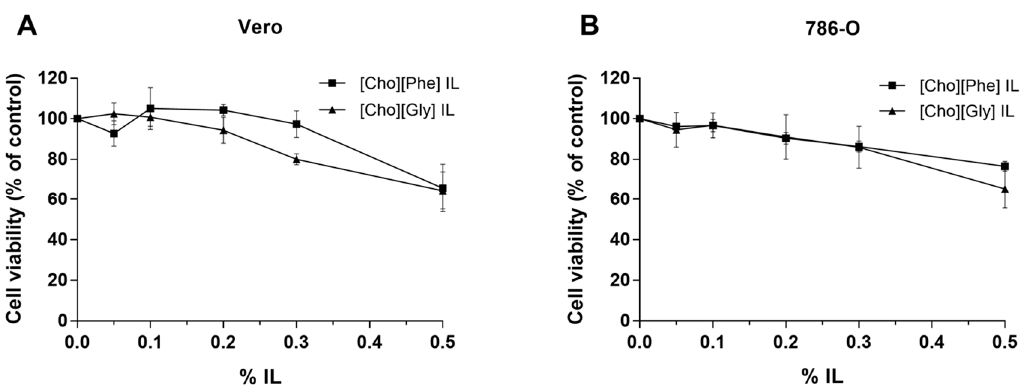
Figure 2. Cell viability of Vero ( A ) and 786-O ( B ) cells exposed to choline-amino acid ILs (0%–0.5%, v / v ). The cell viability of ILs-exposed cells (48 h) was evaluated by MTT assay. Values represent mean ± SD ( n = 2–5) and are expressed as percentages of the non-treated control cells.